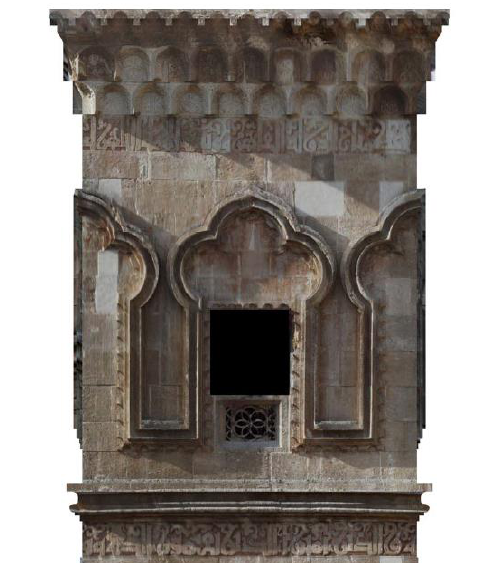
Figure 34 – Wire-frame, solid model and render (by W.Wahbeh and A.Aboufares)